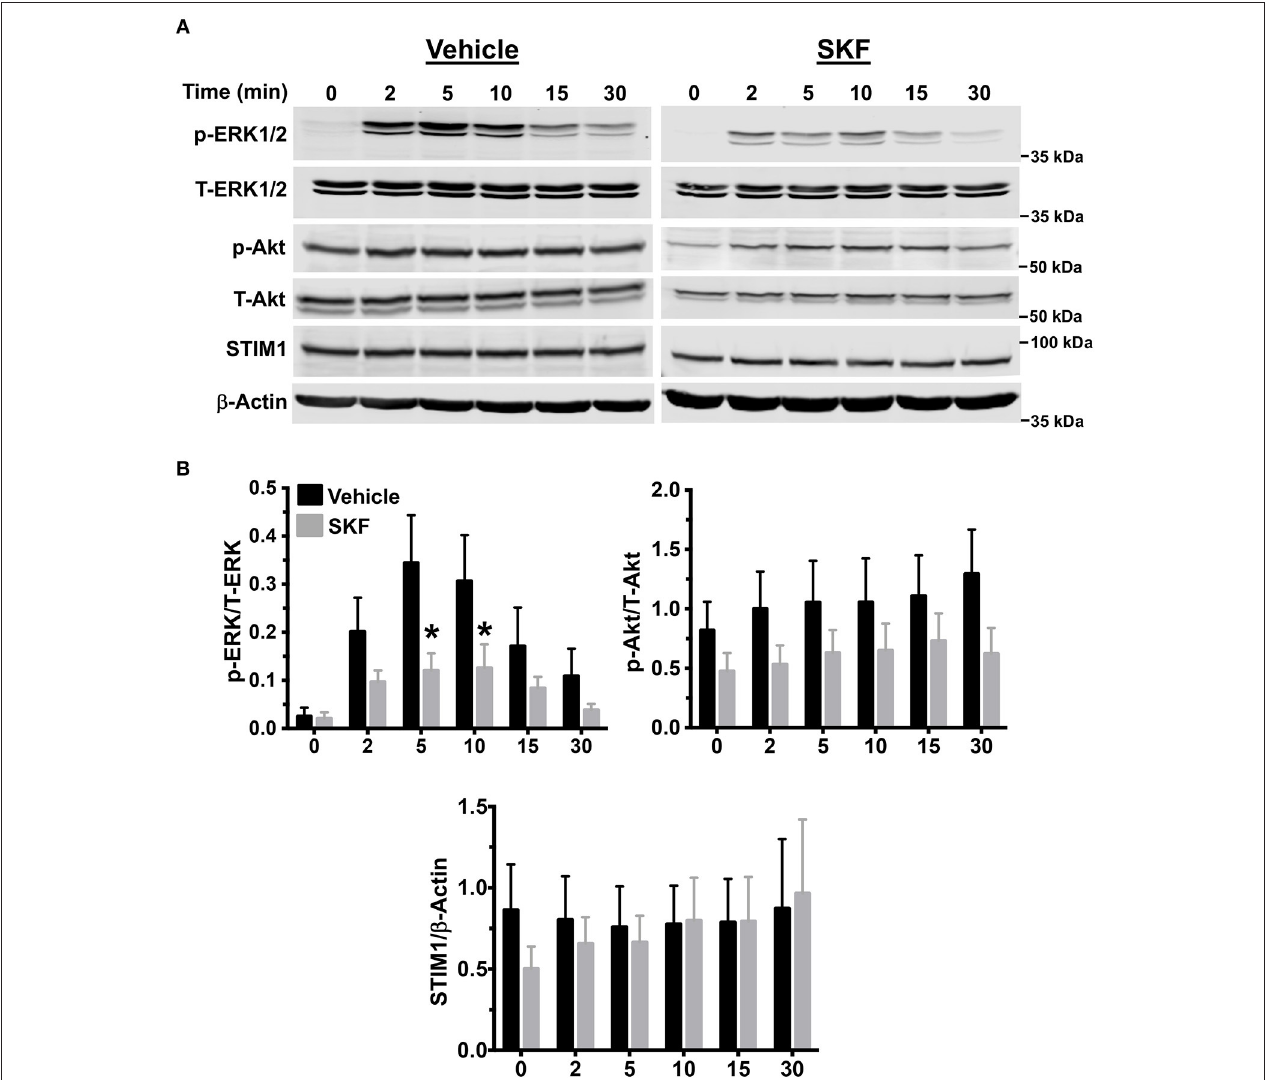
FIGURE 4 | MAP kinase signaling following MRGPRX2 activation is inhibited by SOCE reduction. LAD2 cells were treated with vehicle (PBS) or SKF (30 µ M) and exposed to LL-37 (3 µ M) for different time intervals. (A) Representative western blots are shown. The blots with phosphorylated proteins (p-ERK1/2 and p-Akt) were stripped and reprobed with the total protein (T-ERK1/2 and T-Akt) antibodies. The STIM1 blot was stripped and reprobed with β -Actin (loading control). (B) Bar graphs show relative intensities of bands for the indicated signaling proteins. Phosphoproteins were normalized to total expression for each respective target. STIM1 was normalized to β -Actin levels. Data from three independent experiments are shown. Statistical significance was determined by Student’s t -test. * p < 0.05.